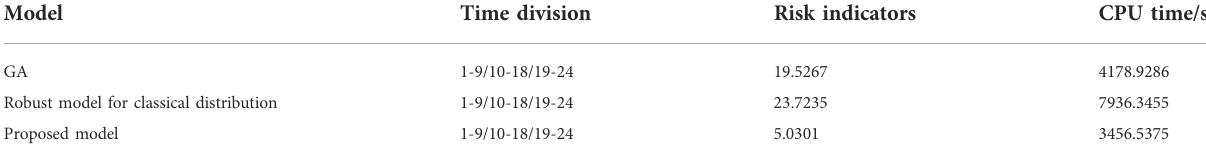
TABLE 8 Comparison of operating